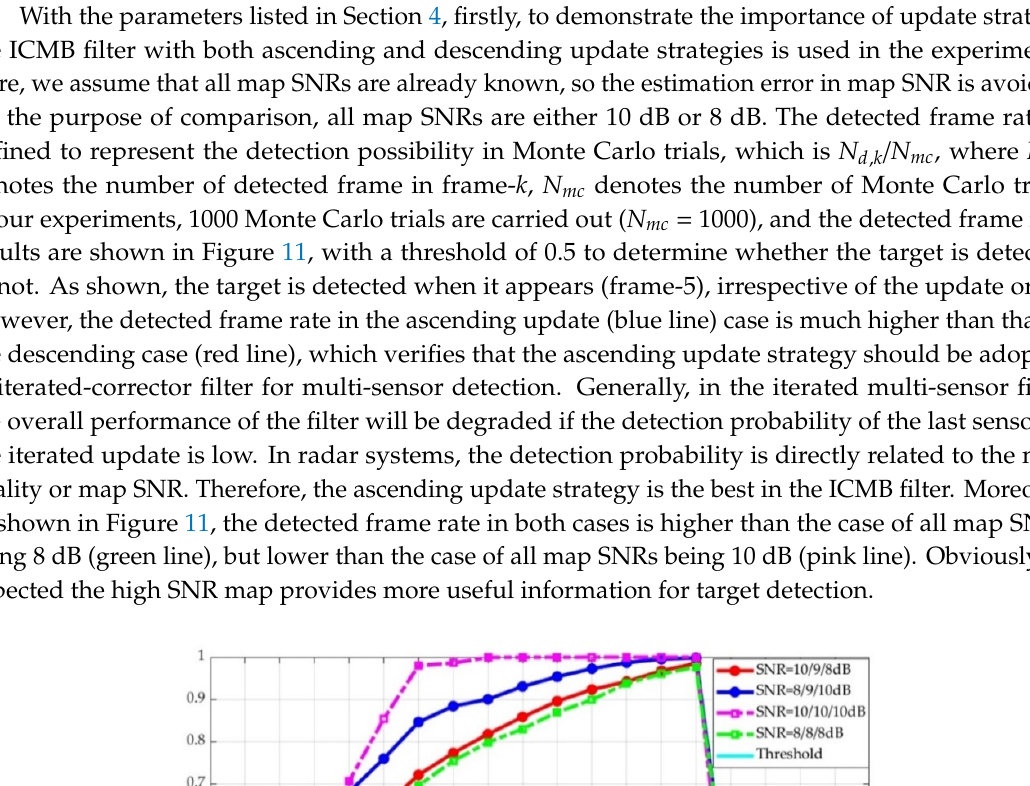
( b ) Figure 12. Root mean square (RMS) error of target position and velocity in different update order cases: ( a ) RMS error of target position; ( b ) RMS error of target velocity. Next, the detected frame rate and RMS errors of the ICMB filter with ascending update order and the PMB filter with all map SNRs being modeled as 8 dB and 10 dB are presented. As shown in Figure 13, a missing alarm will appear if all map SNRs are modeled as 8 dB, because the map quality is underestimated; on the other hand, a false alarm also appears when all map SNRs are modeled as 10 dB, as the map quality is overestimated. Obviously, the detected frame rate and RMS error of the ICMB filter and the proposed filter are between the two extreme cases of all 8 dB and all 10 dB, as shown in Figures 13 and 14. However, when the target appears initially, the performance of the ICMB filter is much better than the proposed filter r, as shown by the blue line and red line in Figures 13 and 14. The reason is that the estimation accuracy of map SNR by the proposed estimation method is not high enough, which affects the order of updates and the likelihood function in (15). As shown in Figure 9, the estimation accuracy of map SNR is gradually enhanced with the increasing number of map frames. After a few frames, the map SNR is estimated more accurately, and the ascending update can be realized and the likelihood function can also be modeled accurately. Therefore, as shown by the blue line and red line in Figures 13 and 14, the performance of those two filters is almost the same after a few frames, and the effectiveness and accuracy of the proposed filter are also verified.